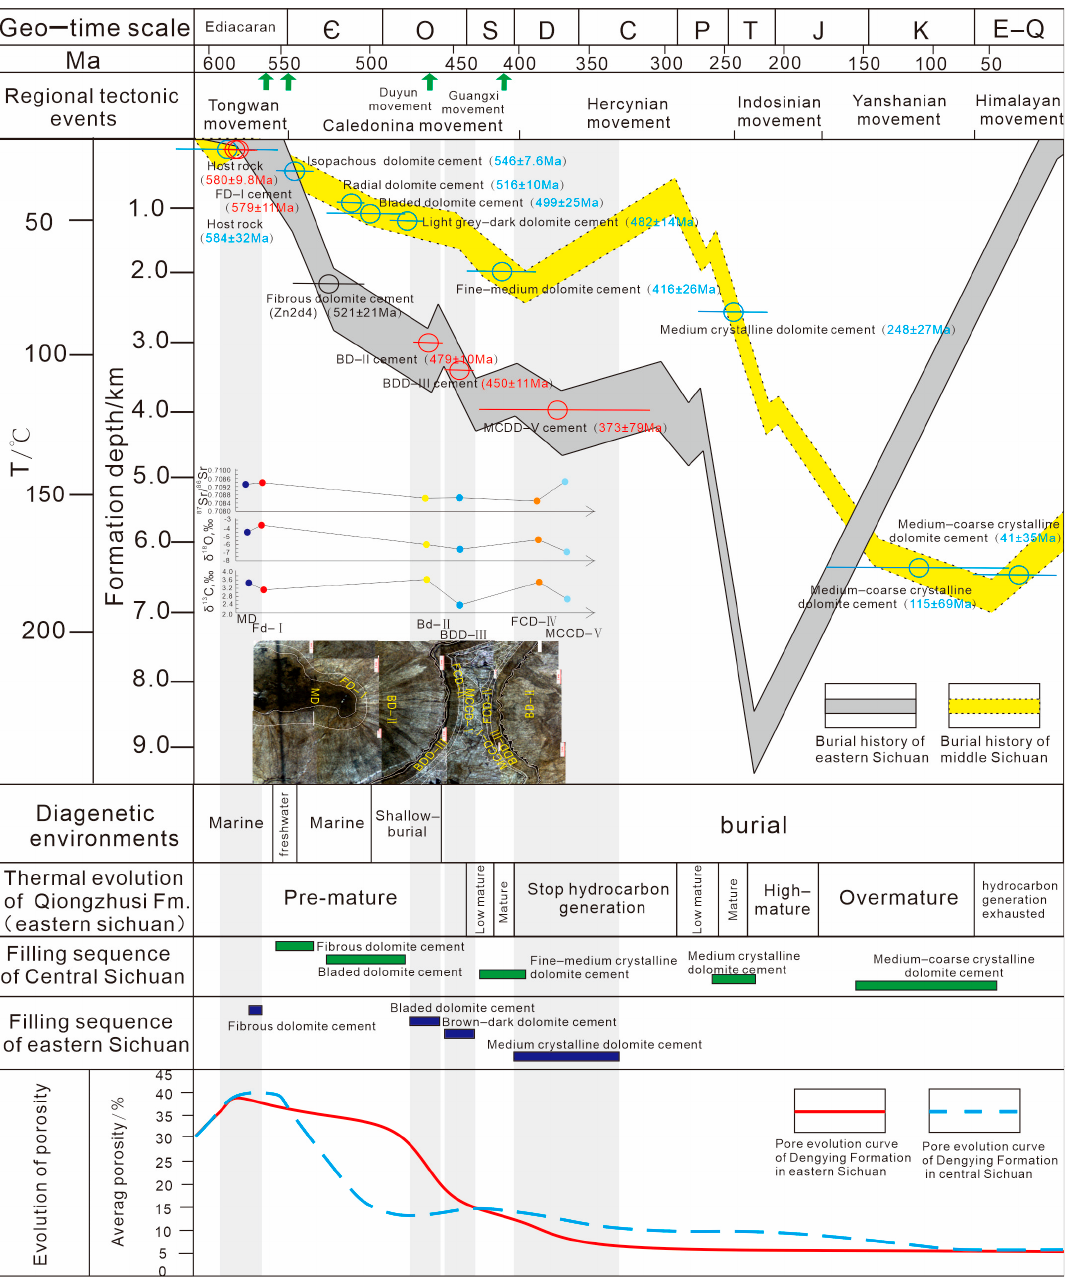
Figure 8. Burial history of the Ediacaran Dengying Formation, Sichuan Basin (the burial history of Eastern Sichuan is modified from [44]; that of Central Sichuan is modified from [45]; the porosity curve of Central Sichuan refers to [24]).